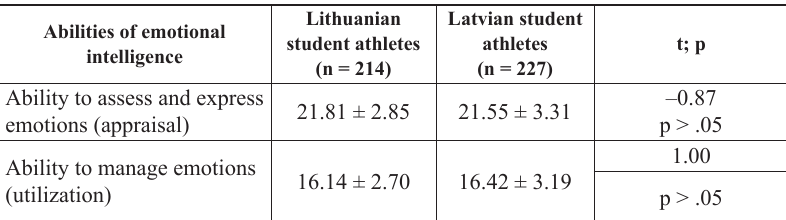
Table. The statistical indicators of the abilities of emotional intelligence among Lithuanian and Latvian student athletes (M ± SD)